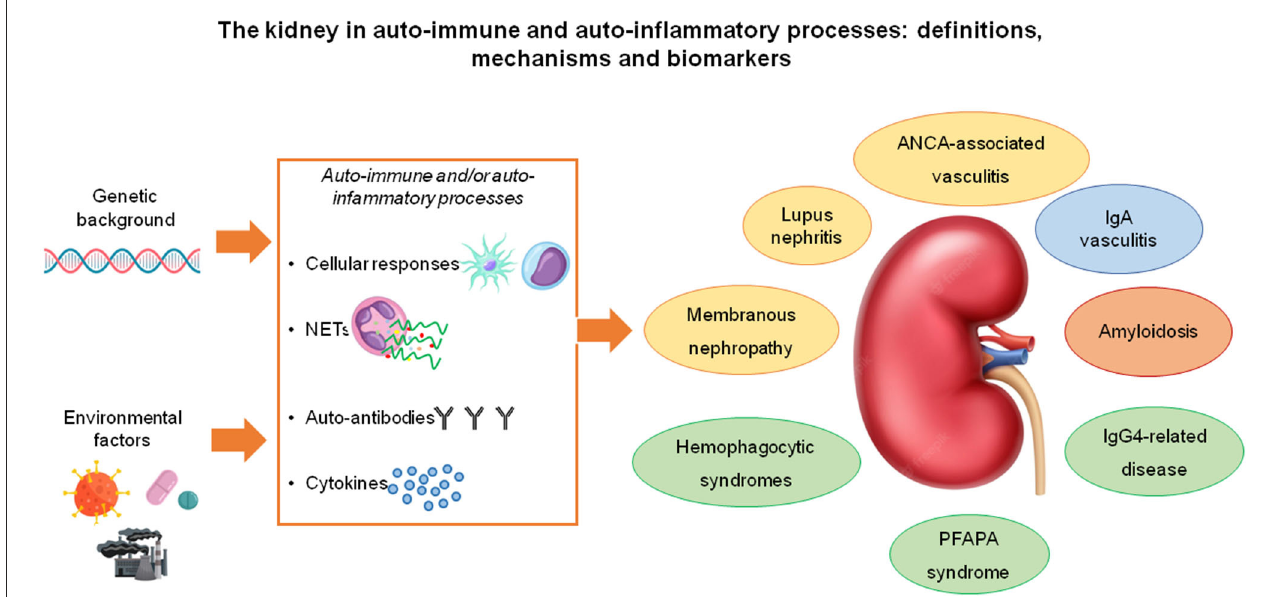
FIGURE1 Most of the immune-mediated, systemic diseases that affect the kidney are “complex diseases” that result from the interaction between genetic susceptibility factors and environmental factors. The pathogenic mechanisms through which they cause kidney disease involve T-cell and macrophage/dendritic cell-mediated immunity, neutrophil activation and NET (neutrophil extracellular trap) formation with the exposure of auto-antigens and the consequent stimulation of autoimmune responses, the production of autoantibodies and the secretion of immuno-modulatory cytokines. The diseases included in this spectrum may have well-known pathogenic autoantibodies (e.g., lupus nephritis, ANCA-associated vasculitis, membranous nephropathy- all highlighted in yellow), pathogenic immune-complexes (IgA nephropathy, highlighted in blue), pathogenic monoclonal or polyclonal proteins able to form amyloid (amyloidosis, in orange), autoinflammatory or yet unknown pathogenic hallmarks (all the conditions highlighted in